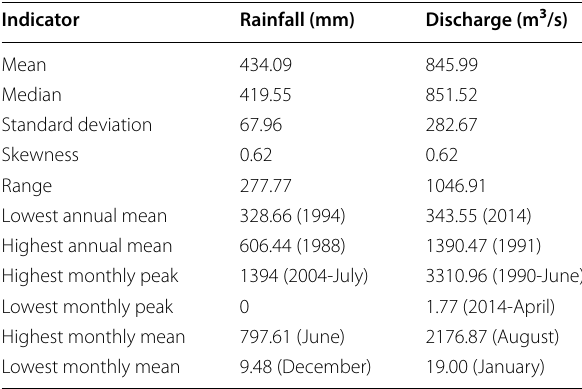
Table 1 Annual mean rainfall and Discharge Scenario